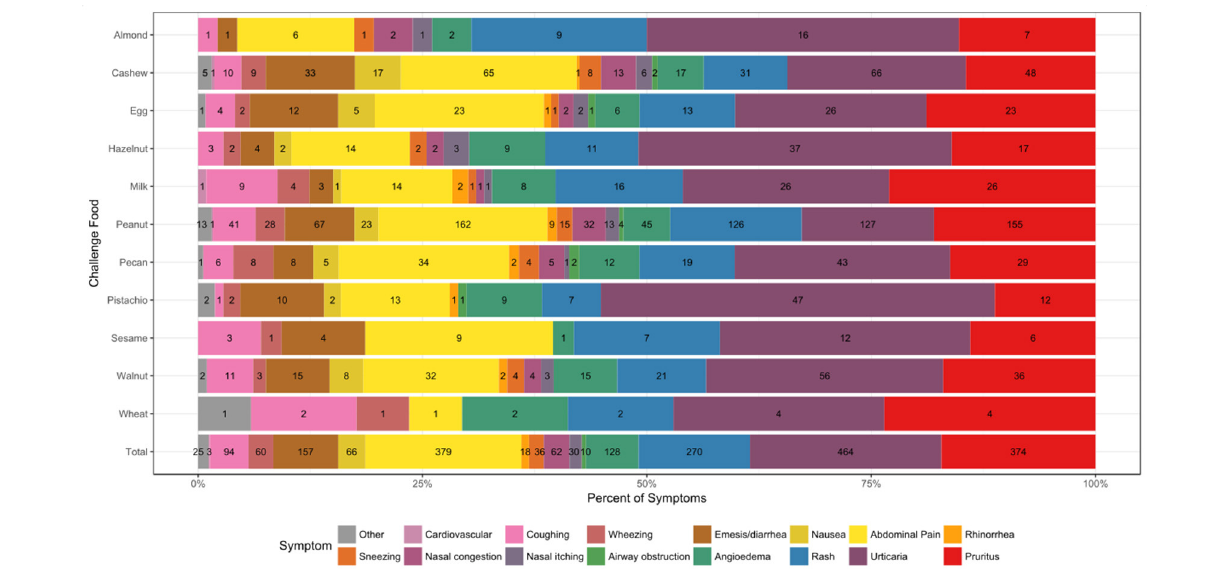
FIGURE 4 | Symptom type by allergen. Reaction counts are reported within the